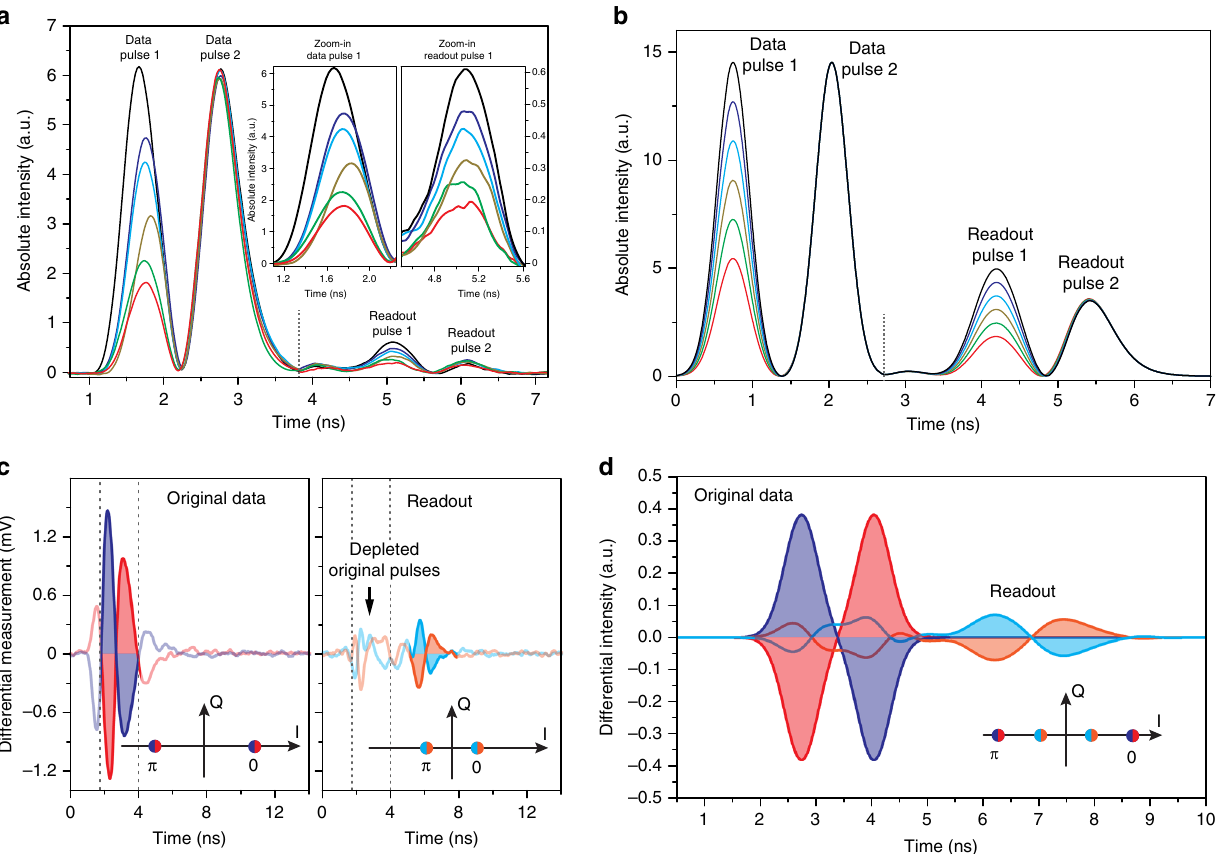
Fig. 3 Amplitude and phase encoded signals. a Six different amplitude levels (depicted by the different colours) of a 500 ps optical pulse can be stored and retrieved after a storage time of 3.5 ns via direct detection. The amplitude of pulse 2 remains constant for the original and retrieved data pulse. The read- out ef fi ciency of pulse 2 is lower due to practical limitations in the experiment (power limitation). The inset shows a zoom-in on the input amplitude levels and the readout amplitudes. b Simulation data of the amplitude response of the system. c Two phase levels of two 500 ps optical pulses, either 0 and π or π and 0 (depicted by the red and blue trace, respectively) are retrieved via homodyne detection after a storage time of 3.5 ns ( orange and light blue trace ). The insets show the two phases in phase space for the original ( red / blue ) and retrieved ( orange / light blue ) pulses. d Simulated phase response of the system (the colour schemes of the two encoded phases and the phase space diagram are according to the measurements depicted in c